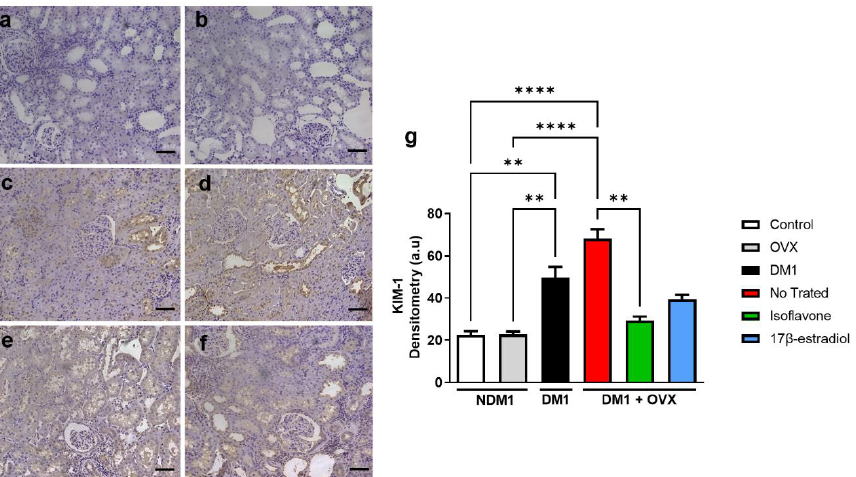
Figure 4. Isoflavone protects diabetic renal tissue of ovariectomized animals. Immunoreactivity of KIM-1 by immunohistochemistry ( a – f ). Control ( a ), OVX ( b ), DM1 ( c ), untreated DM1 + OVX ( d ), DM1 + OVX treated with isoflavone ( e ), and DM1 + OVX treated with 17 β -estradiol ( f ). Densitometry analysis is represented in arbitrary units ( g ). Scale bar = 50 µ m. Values represent mean ± SEM ( n = 6). Kruskal–Wallis test was performed, followed by Dunn’s multiple comparison test for non-normal distribution of data. ** p < 0.01; **** p <